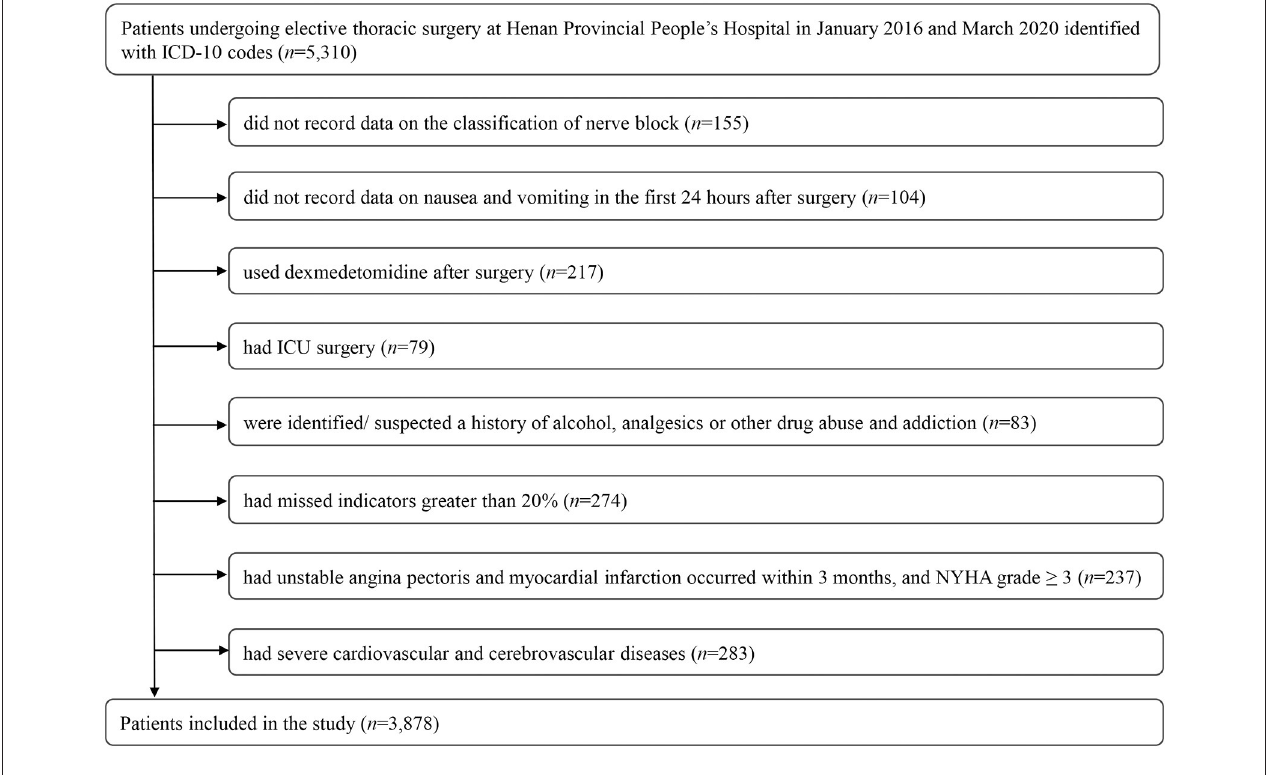
FIGURE 1 | Flow chart for final patient selection in this study. DEX, dexmedetomidine; ICU, Intensive Care Unit; NYHA, New York Heart